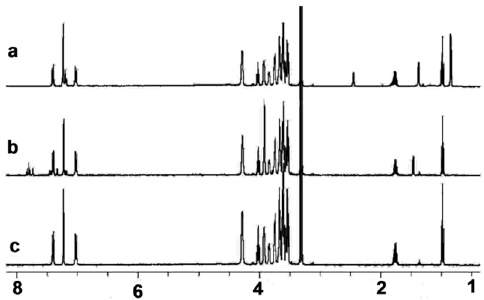
Figure 8. 1 H-NMR spectra of ( a ) the 2 + IBP complex, ( b ) the 2 + NAP complex, and ( c ) 2 in D 2 O, [2] = [NAP] = [IBP] = 1.0 × 10 − 4 mol/L in all tests.